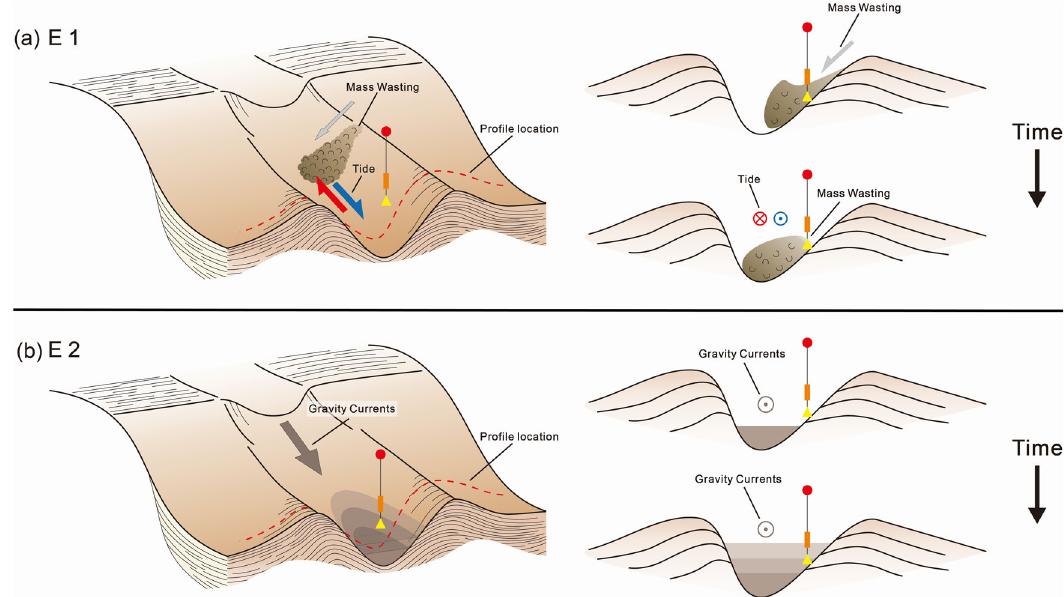
Fig. 7 The schematic diagrams of the turbidity currents E1 and E2 (not to scale). a The formation process of the turbidity current E1. The sediment from mass wasting moves down the trench under gravity and is promoted by tidal currents. b The fl ow thickness of turbidity current E2 is gradually thickening when the front of E2 gets through the mooring site